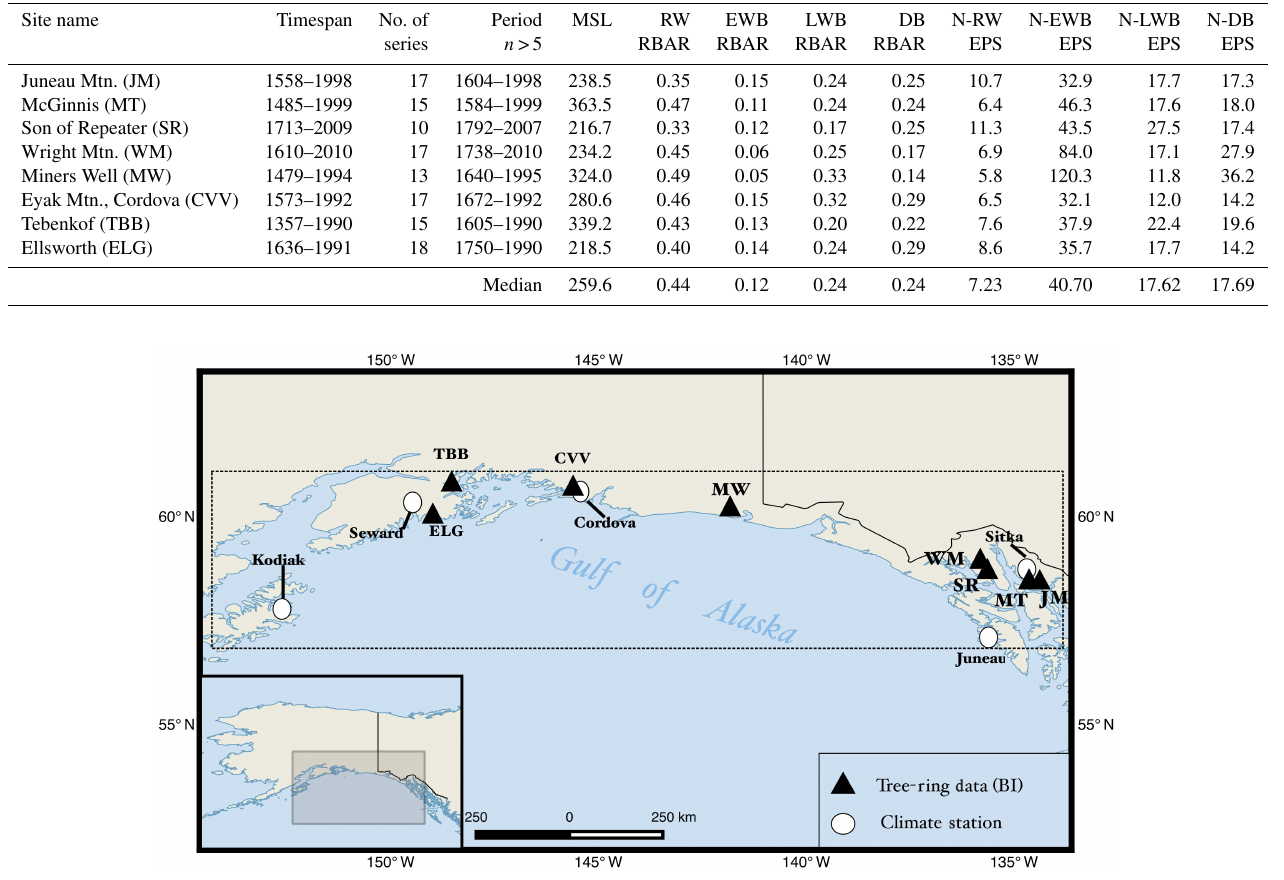
Figure 1. Location map of the eight GOA tree-ring sites used in this study (Table 1). Also indicated (dashed line box) is the domain (57– 61 ◦ N, 153–134 ◦ W) of the gridded data (CRU TS 3.24, Harris et al., 2014; BEST, Rohde et al., 2012) used for calibration and the five coastal GOA temperature stations used in the original five-station mean series (Wilson et al., 2007; see Fig. S1 in the